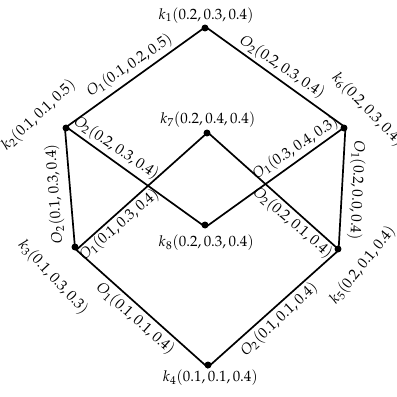
Figure 2. IN subgraph structure.